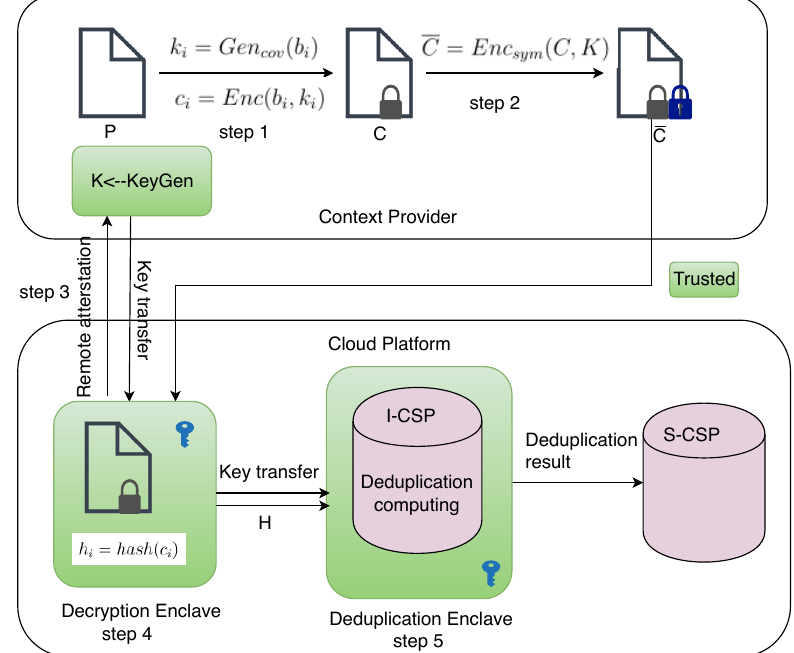
Figure 4. The secure block-level deduplication system based on convergent encryption using